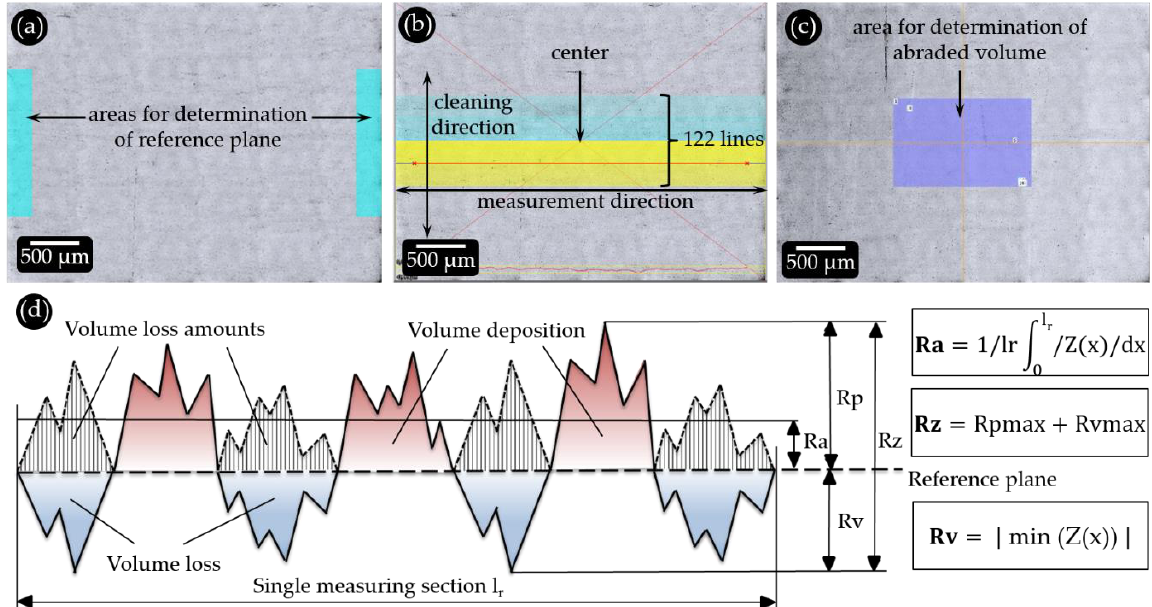
Figure 2. ( a ) Defining the reference surfaces (turquoise areas). ( b ) A total of 122 measurement lines at intervals of 10 pixels at a 90° angle to the cleaning direction. ( c ) Selected area for measuring volume loss (purple area). ( d ) Schematic depiction of how the roughness parameters Ra, Rz and Rv are defined, including the formulae used for their calculation, according to [14].